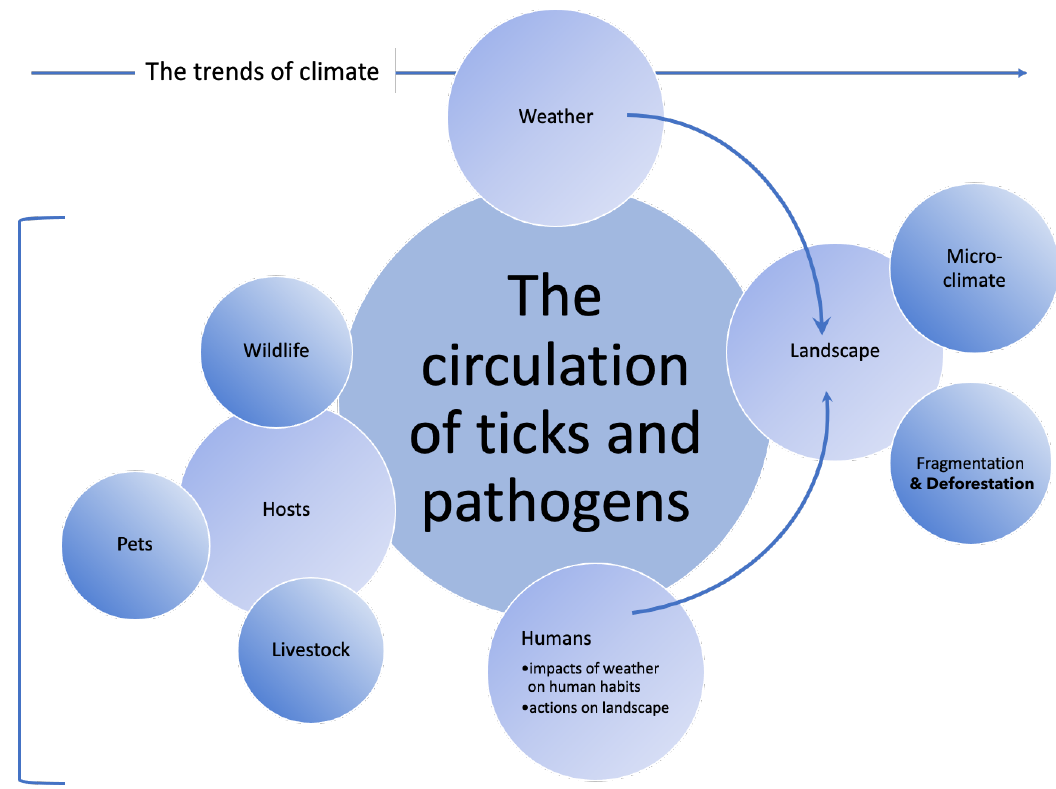
Figure 1. A schematic view of the traits affecting the circulation of tick-borne pathogens. We aimed to represent the main factors that affect the physiology of ticks (survival, development), their